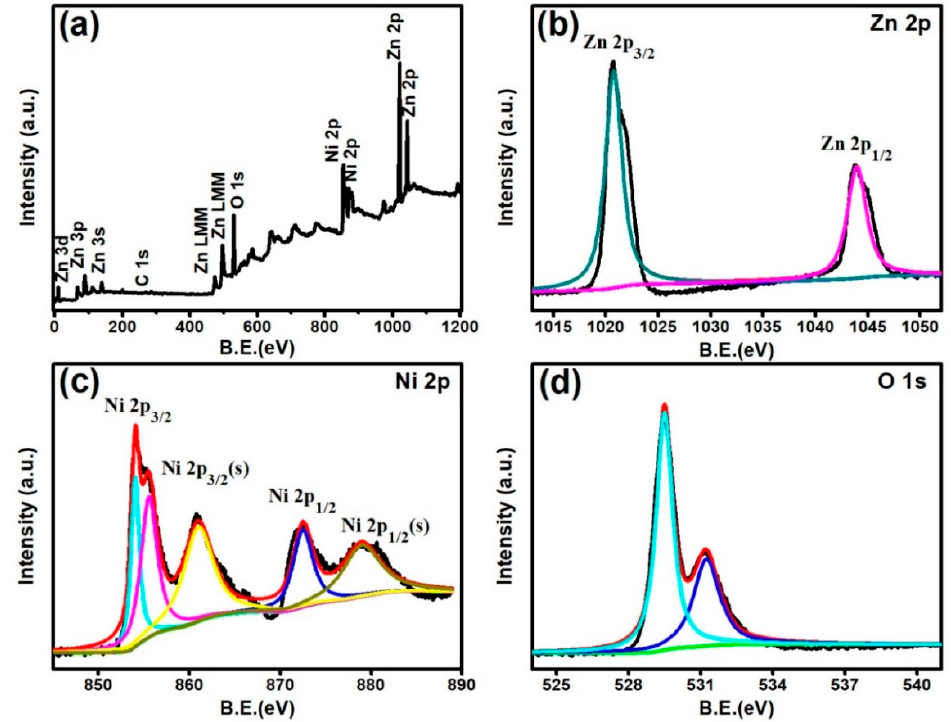
Figure 5. XPS survey spectra of Zn 1 Ni 2 ( a ), high resolution spectra of Zn 2p ( b ), Ni 2p ( c ) and O 1s ( d ).